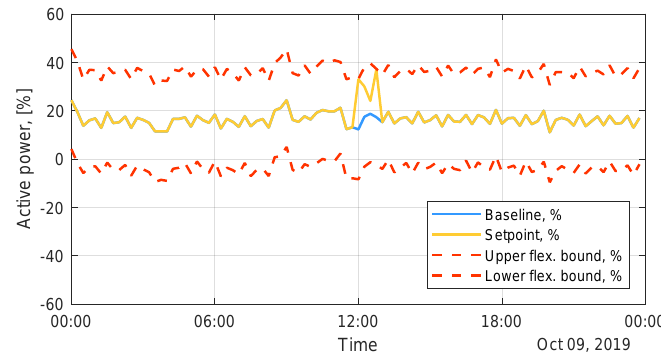
Figure 16. Control action. HEMS connected to node 28.